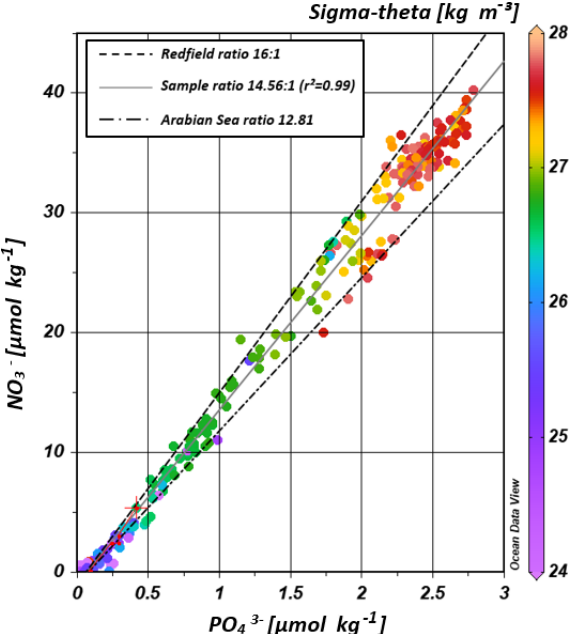
Figure 8. Correlation of nitrate vs. phosphate concentrations. Re- gression line of the sample pool (solid, grey line) indicates a ratio of ∼ 14 . 56 ( r 2 = 0 . 99), intermediate between the Redfield ratio of 16 : 1 (black, dashes line) and the mean ratio in the Arabian Sea with a slope of ∼ 12 . 81 (grey, dotted-dashed line) following Codispoti et al. (2001). Colour coding of dots indicates the potential density sigma-theta in kilograms per cubic metre (kgm − 3